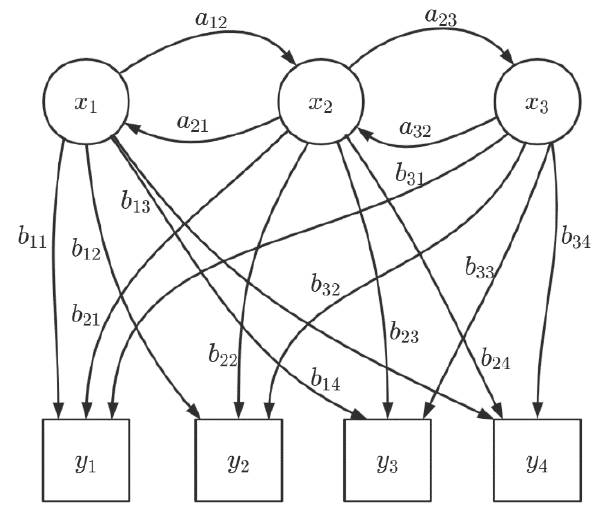
Figure 2. A graphical model of the HMM.